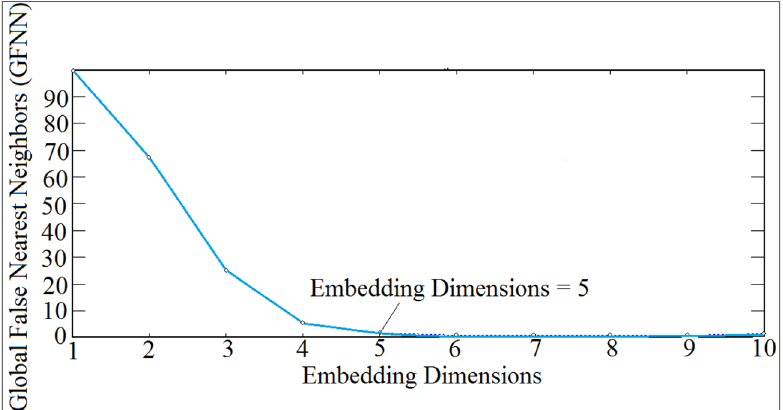
Figure 22. Embedding dimensions of experiment test.